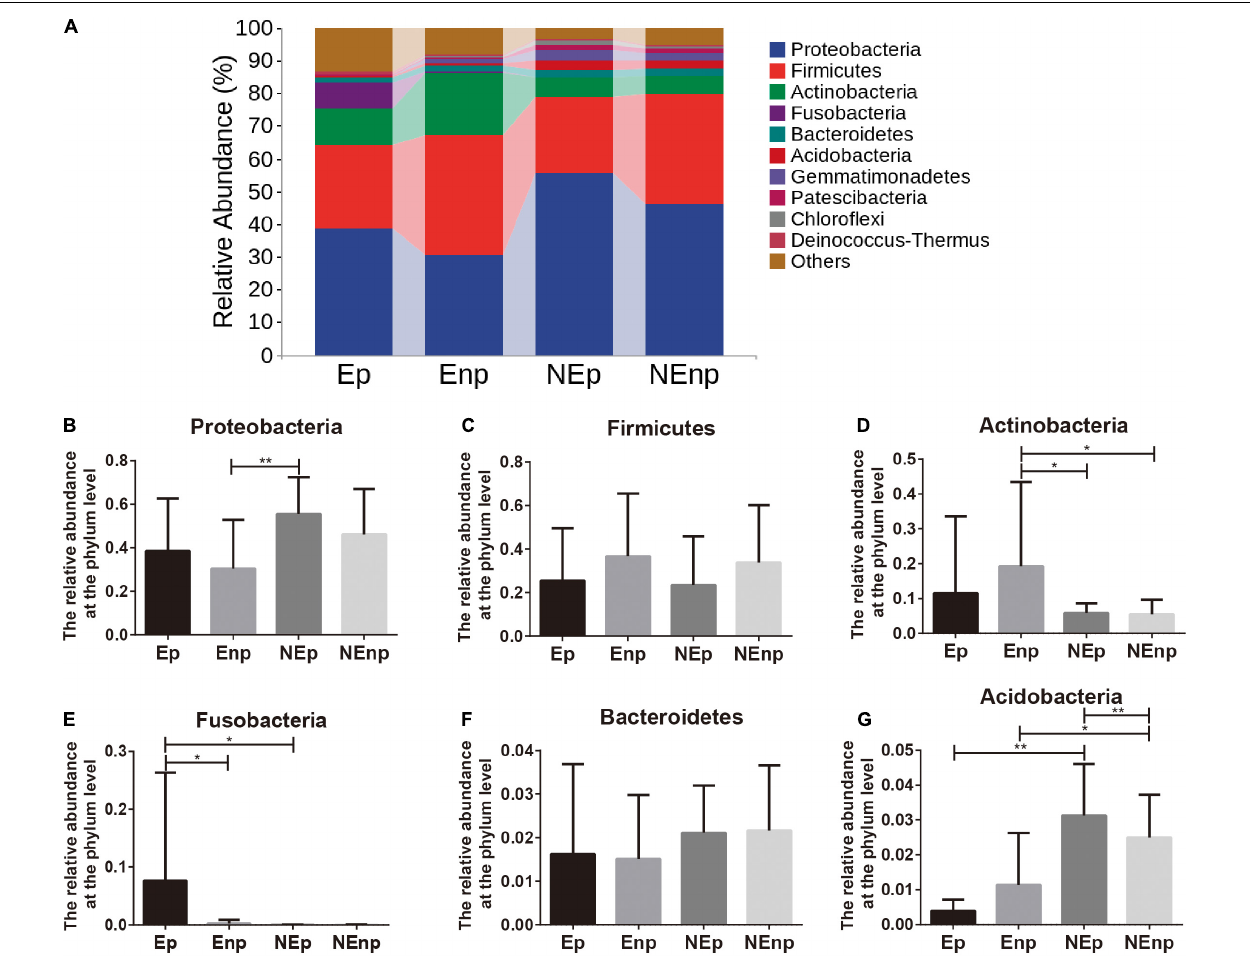
FIGURE 4 | Relative abundance of uterine microbiota at the phylum level. (A) The relative abundances of the top 10 bacteria at the phylum level. The relative abundances of (B) Proteobacteria, (C) Firmicutes, (D) Actinobacteria, (E) Fusobacteria, (F) Bacteroidetes, and (G) Acidobacteria. Values are expressed as mean ± SD. * q < 0.05, ** q <